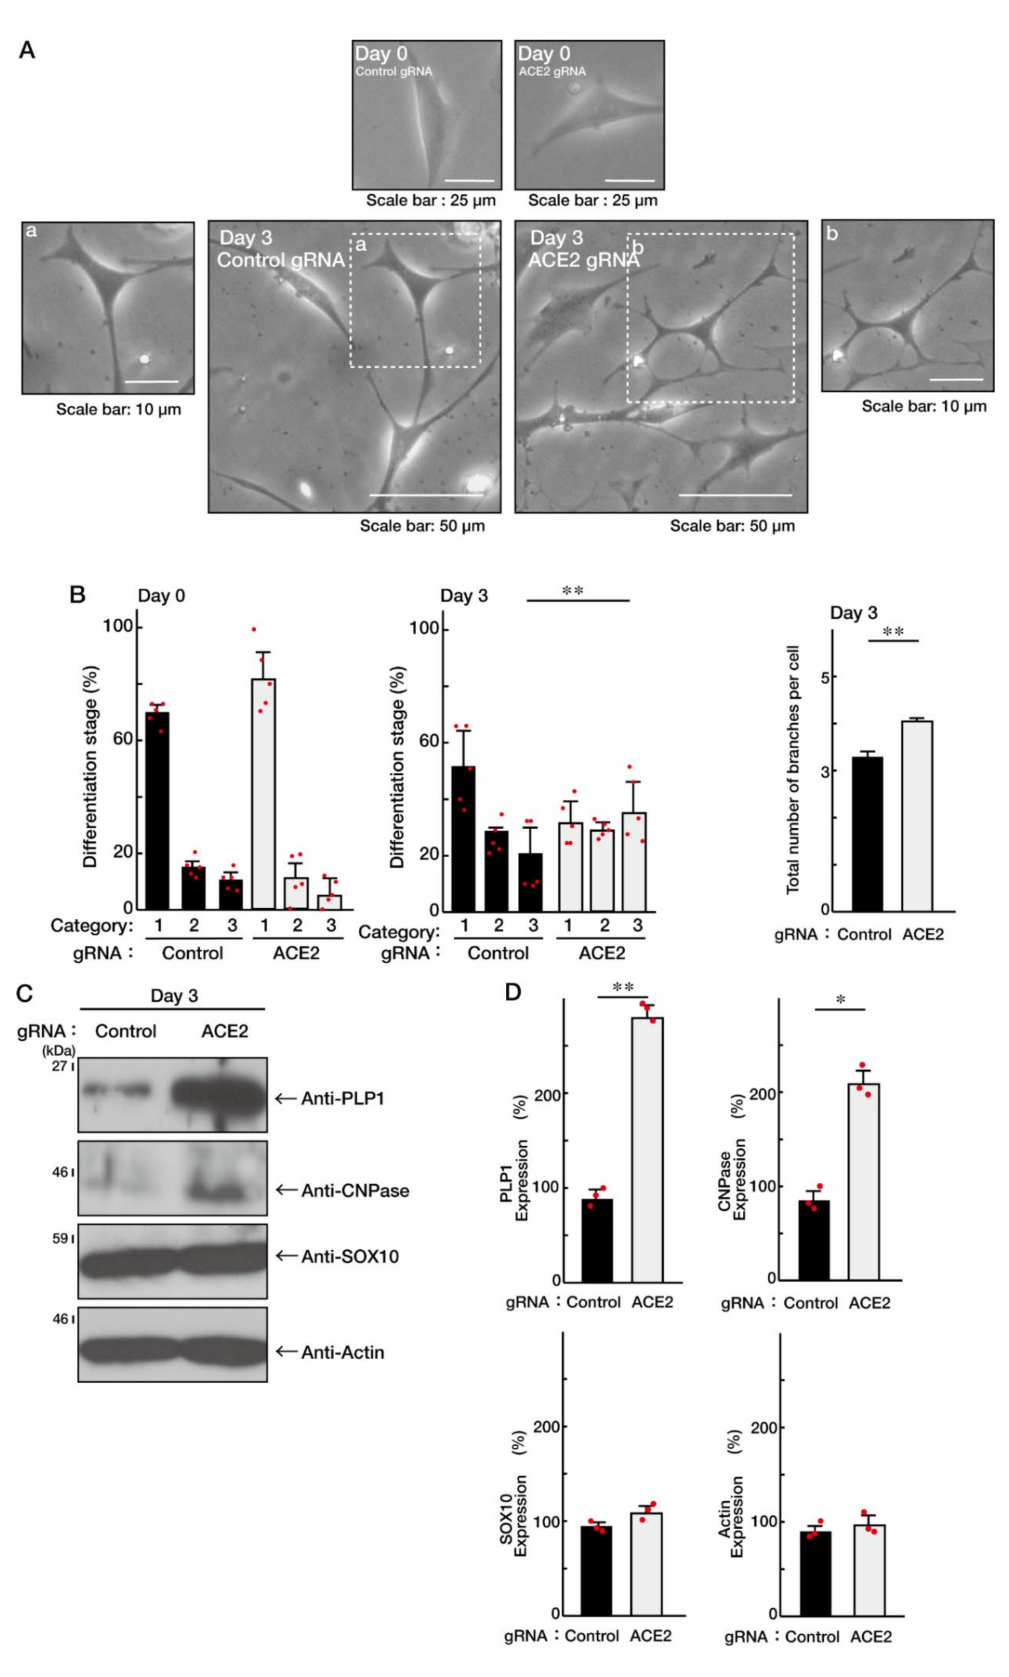
Figure 2. Knockdown of ACE2 by gRNA promotes oligodendroglial cell morphological